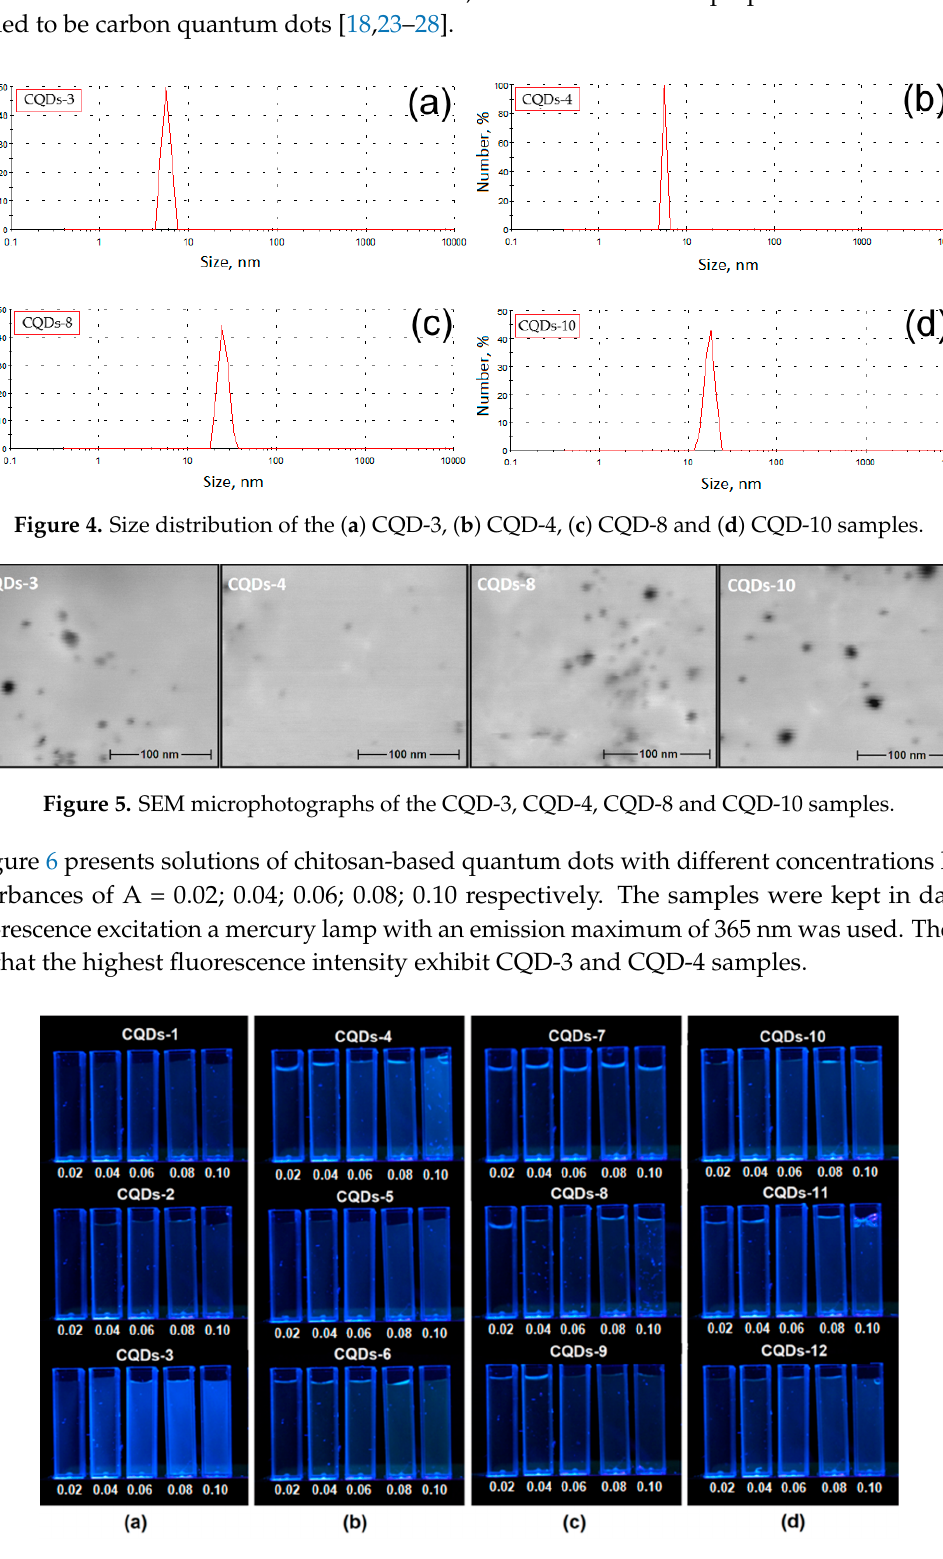
Figure 6. Chitosan-based CQDs under UV radiation ( a ) CQDs1-3 samples, ( b ) CQDs4-6 samples, ( c ) CQDs7-9 samples and ( d ) CQDs-10-11 samples. ( c ) CQDs7-9 samples and ( d ) CQDs-10-11